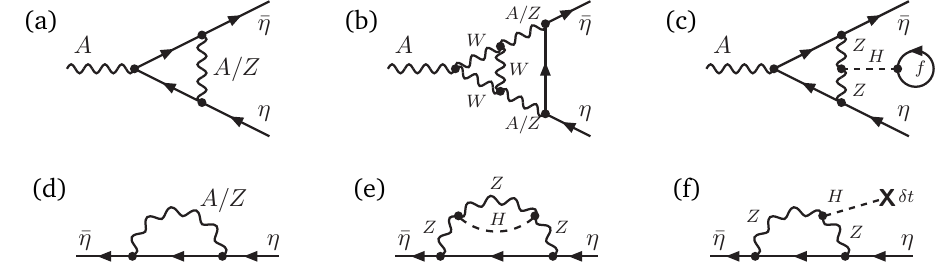
ηη Γ ¯ ηη (d–f), µ (a–c) and